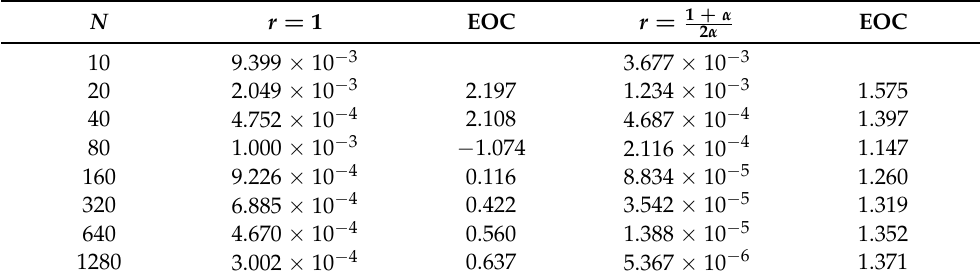
Table 5. Table showing the maximum absolute error and EOC for solving (27) using the predictor- corrector method for α = 0.4.